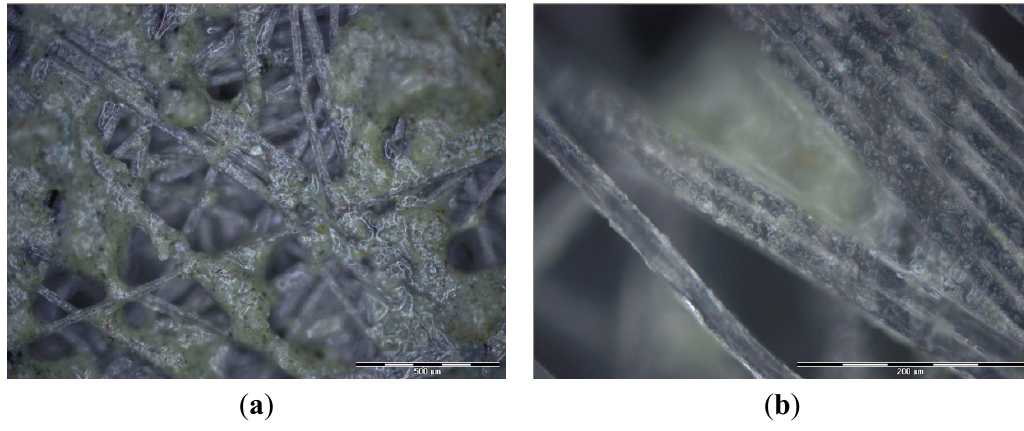
Figure 10. Filter Rig No. 3 lower geotextile at 5× magnification ( a ); and 20× magnification ( b